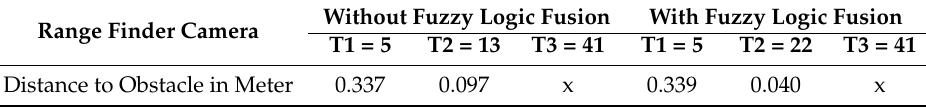
Table 3. Distance measurements by camera before and after implementing the fusion model.